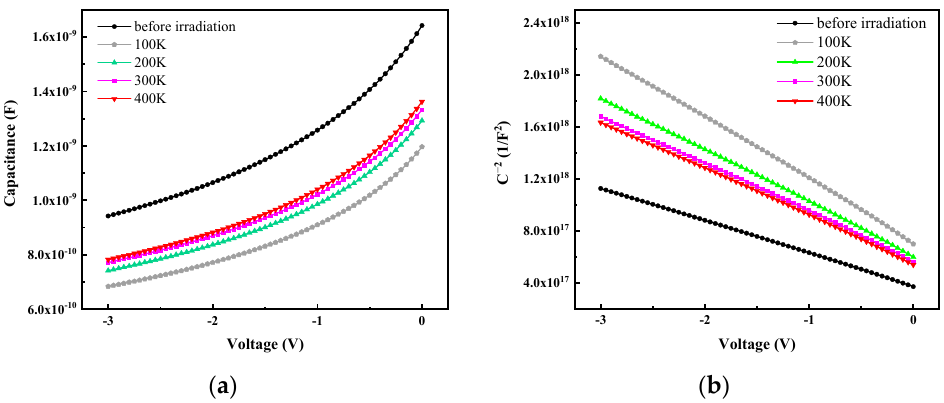
Figure 4. ( a ) C–V and ( b ) C − 2 –V characteristics of 4H-SiC diodes before and after proton irradiation measured at room temperature.